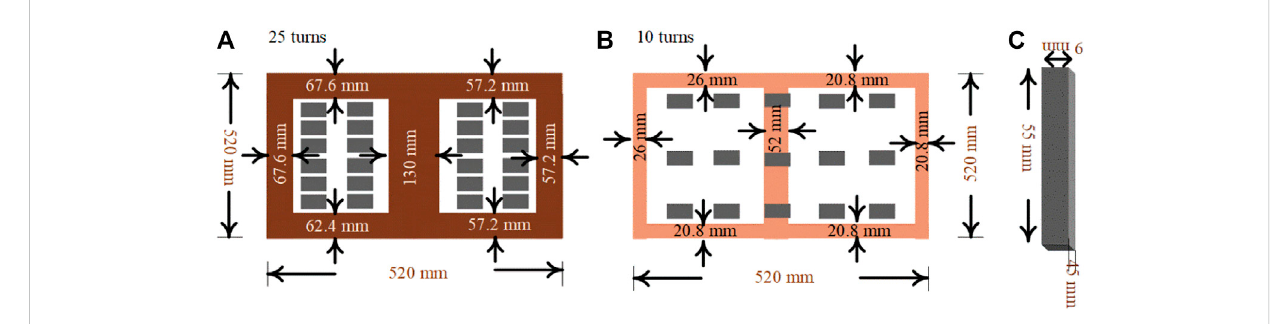
FIGURE 9 Dimensions of (A) transmitter pad (B) receiver pad (C) ferrite